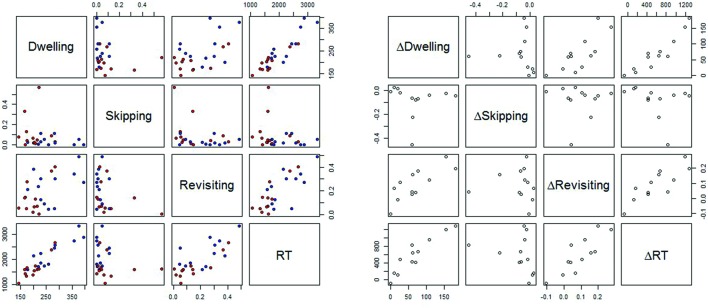
(Left) Bivariate relationship between the means of RT, revisiting rate (Revisiting), skipping rate (Skipping), and dwell time (Dwelling), for target absent trials. Each subject contributes two data points, which are the means for dissimilar (red dots) and similar (blue dots) targets. (Right) Bivariate relationship between ΔRT, ΔDwelling, ΔSkipping, and ΔRevisiting, respectively, with Δ denoting the difference between the means in the similar and the dissimilar condition.